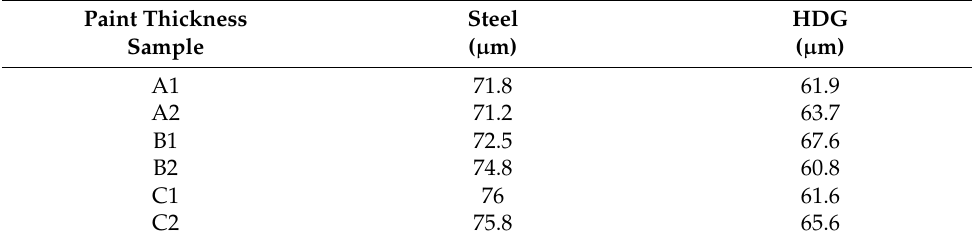
Table A1. Coating thickness for samples aged in